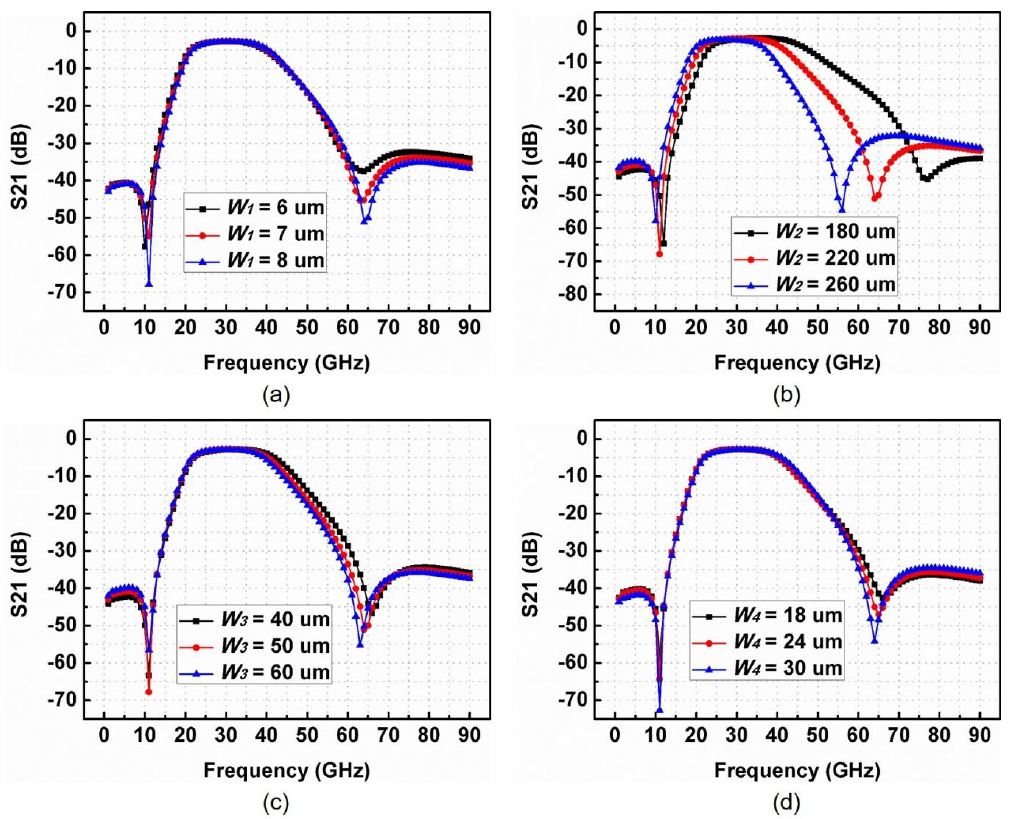
Figure 7. Insertion loss under different values of ( a ) W 1 , ( b ) W 2 , ( c ) W 3 , ( d ) W 4 .